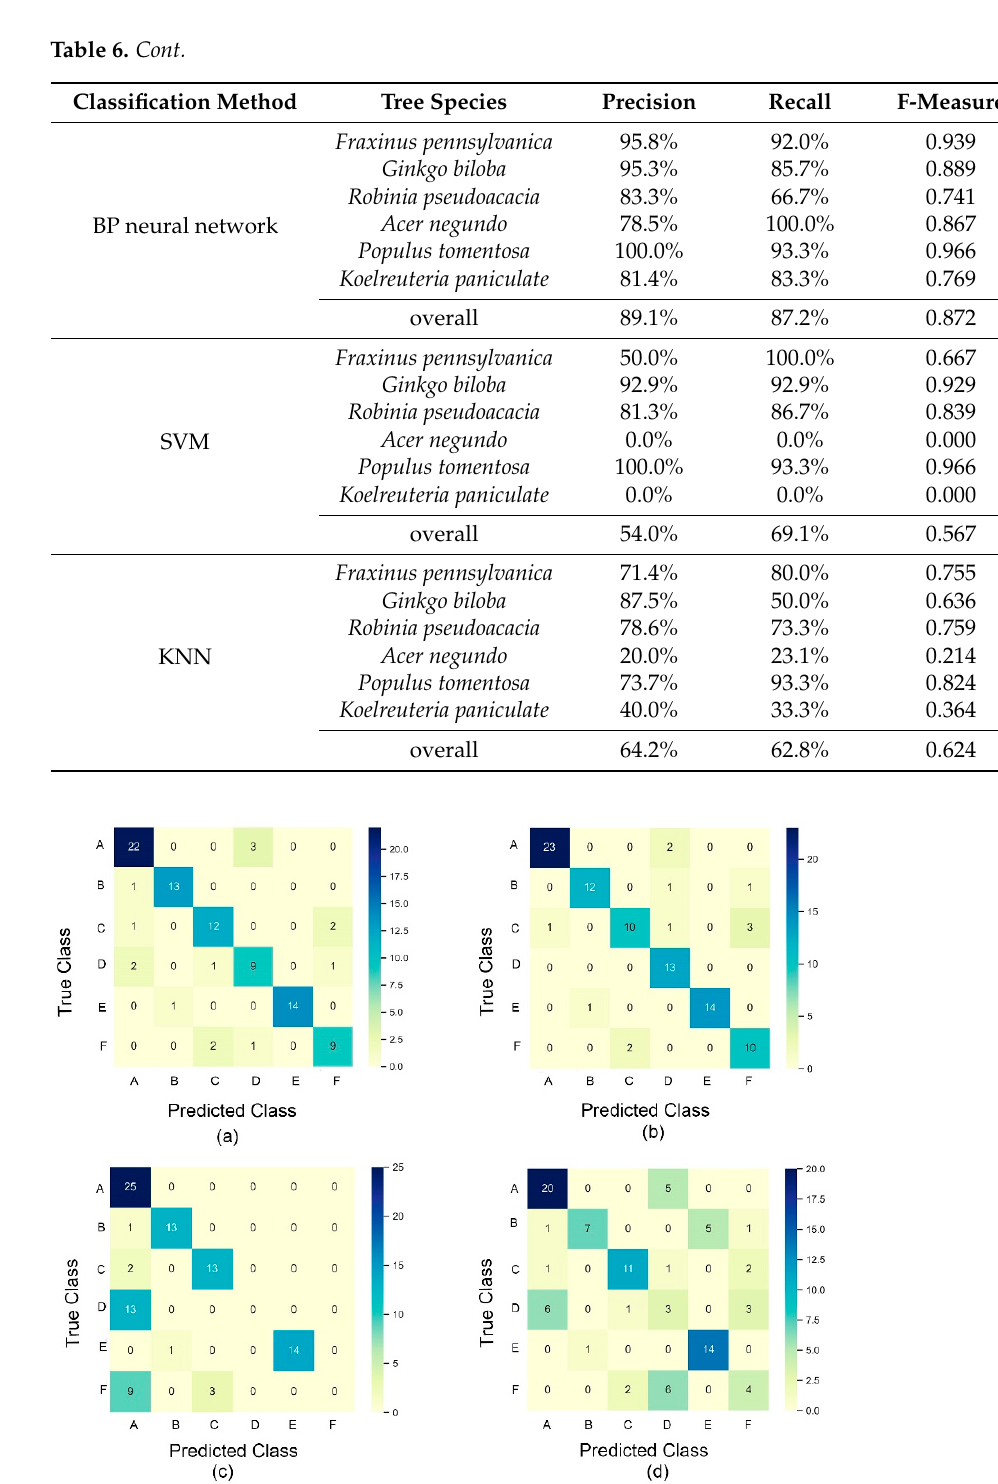
Figure 8. Classification results for each tree species using combined attributes. A, B, C, D, E, and F represent Fraxinus pennsylvanica , Ginkgo biloba , Robinia pseudoacacia , Acer negundo , Populus tomentosa , and Koelreuteria paniculate, respectively. ( a ) Random forest; ( b ) BP neural network; ( c ) support vector machine; and ( d ) K-nearest